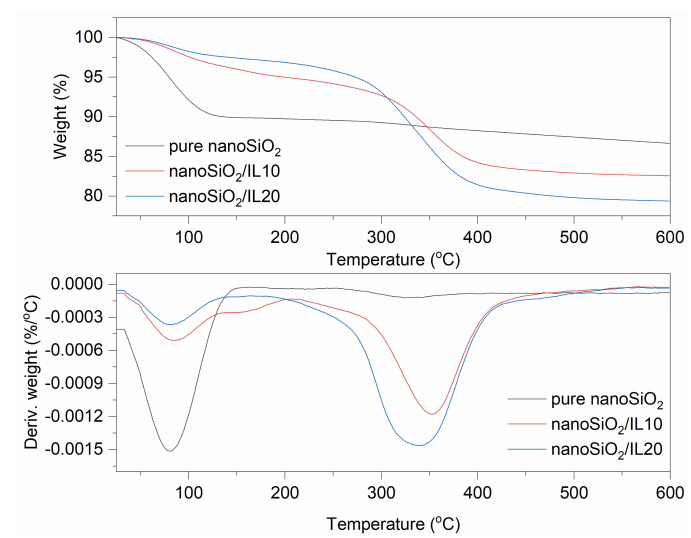
Figure 3. TG and DTG curves for pure and DmiBr-modified nanoSiO 2 .